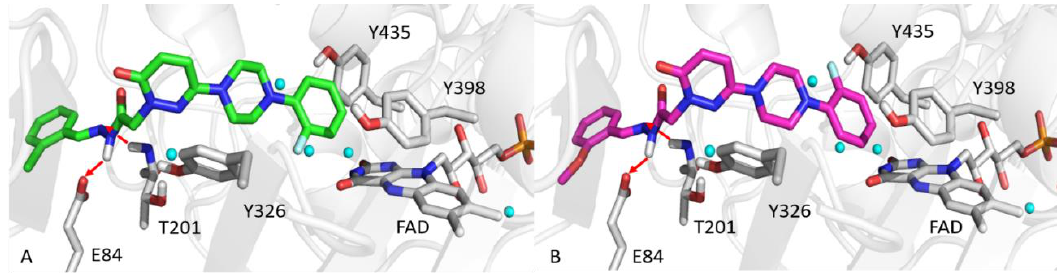
Figure 6. Top scored poses of T3 ( A , green sticks) and T6 ( B , magenta sticks) towards MAO-B. Red arrows indicate hydrogen bonds. Water molecules are rendered as cyan spheres.